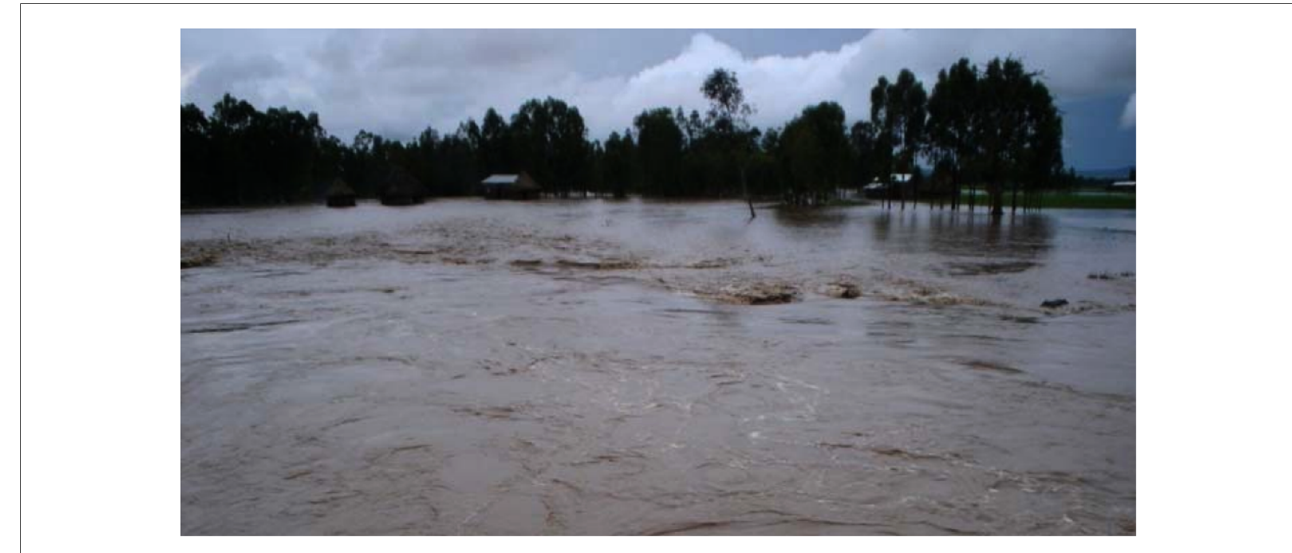
FIGURE 1 Flood case in the study area (in Ribb River Catchment area) (a Picture taken by Woubet Gashaw Alemu in 2007 ( 19